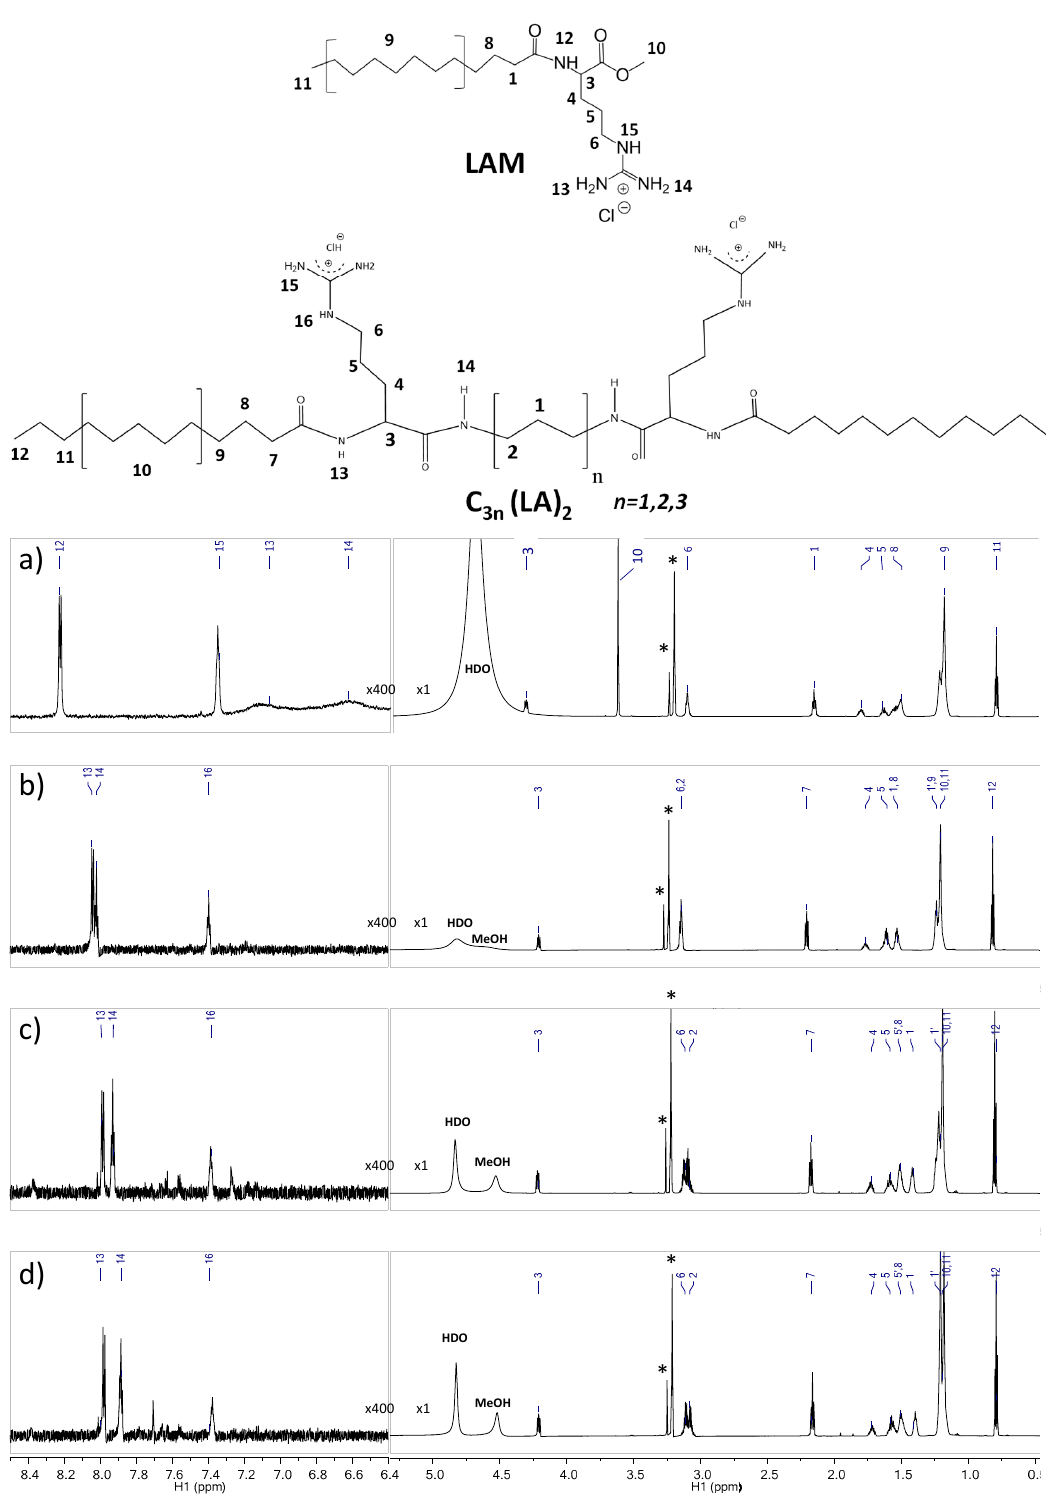
Figure 4. 1 H NMR spectra of pure surfactants ( a ) LAM, ( b ) C 3 (LA) 2 , ( c ) C 6 (LA) 2 and ( d ) C 9 (LA) 2 dissolved in H 2 O:CD 3 OD 4:5 v/v showing the assignment according to the numbering of the chemical structure represented above (Table S2). The left side shows the spectrum in the region from 6.4 to 8.5 ppm with the vertical scale rescaled 400x to show the peaks. Some impurities are denoted with asterisks.